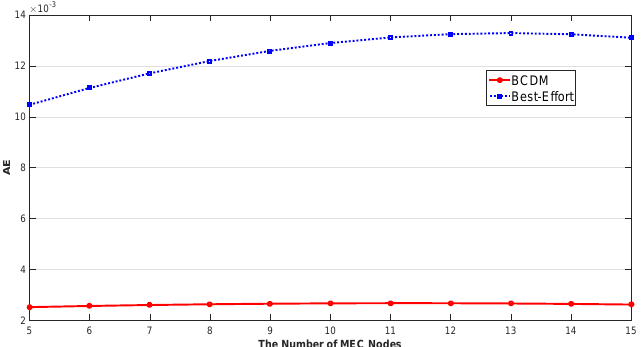
Figure 9. The Impact of the Number of MEC Nodes to Average Energy